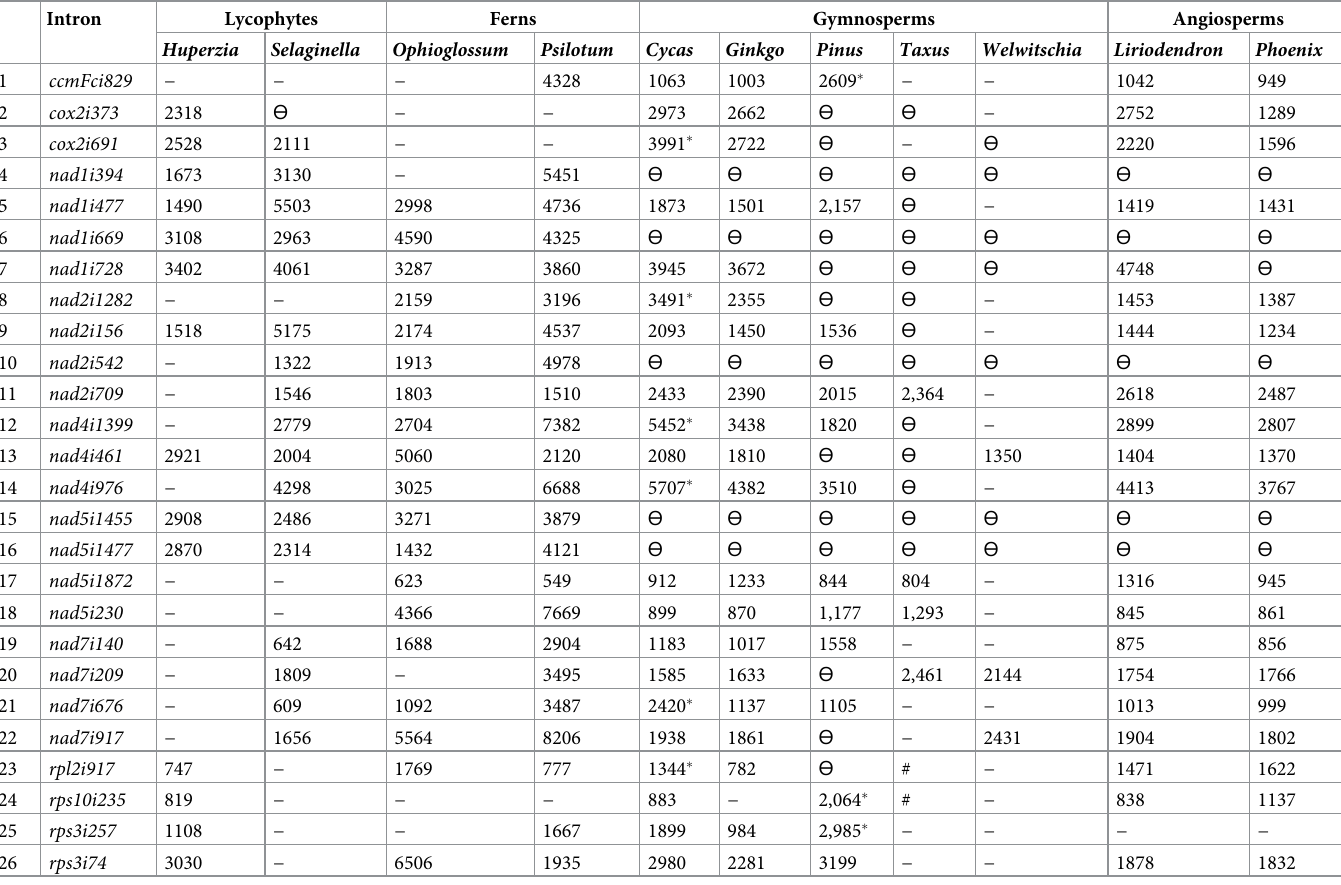
Table 2. Intron size variations among vascular plant